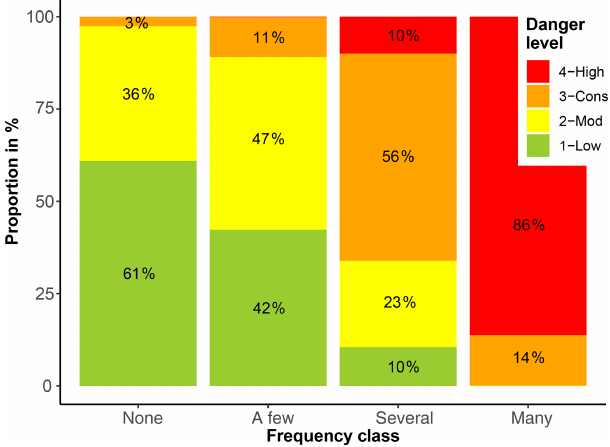
Figure 4. Distribution of the danger levels for the four frequency classes describing the proportion of very poor snowpack stabil- ity, derived from sampling 25 rutschblock tests (as described in Sect. 3.2). The respective proportions are indicated for each of the four danger